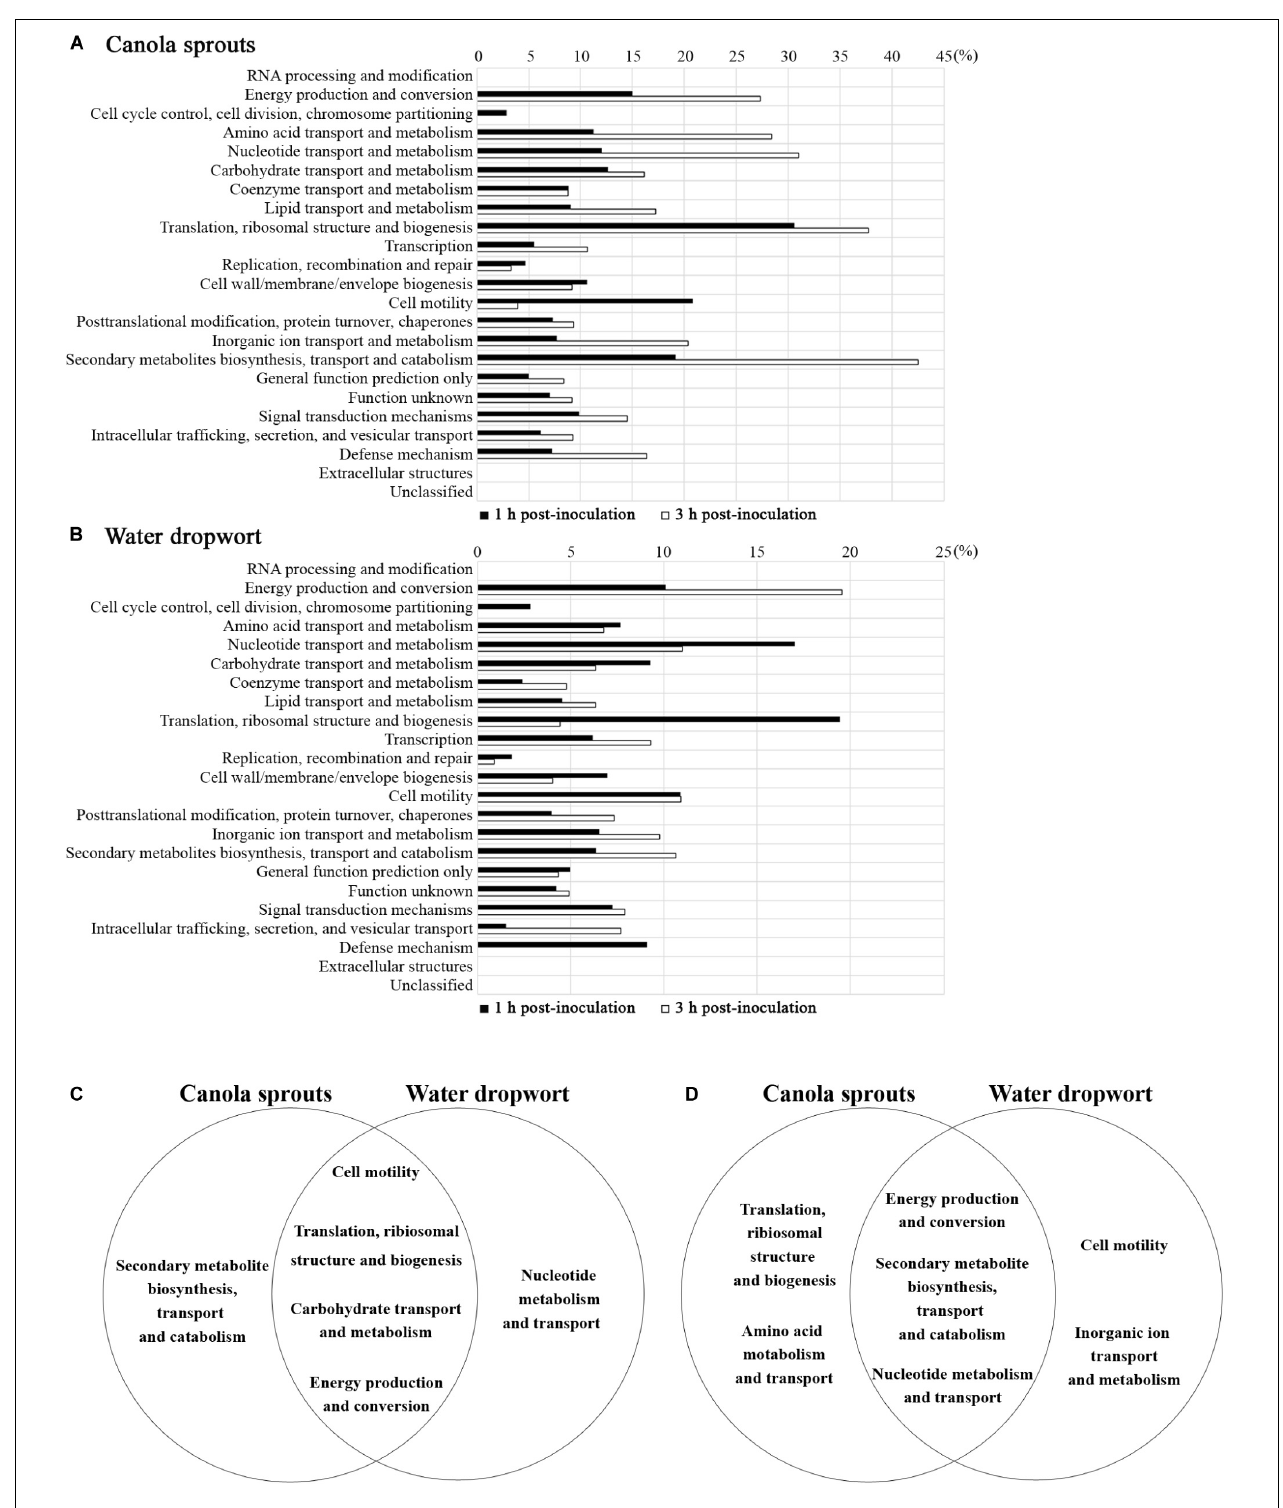
FIGURE 2 | Functional categorization of genes that were differentially regulated upon contact with plants. (A,B) Genes with log 2 [fold change] ≥ 2 or log 2 [fold change] ≤ –2 in response to canola sprouts (A) or water dropwort (B) were grouped based on COG. Bars represent the percentages of increased or decreased genes in a given category after 1 h of exposure ( (cid:4) ) or 3 h of exposure ( ). (C,D) Venn diagram illustrating functional groups with significant expression changes in contact with plants. Five top functional groups showing differential expressions in response to each plant were sorted at 1 h (C) and 3 h (D) post-inoculation. (cid:50) Functional groups identified in both of plants in common were placed in the intersections of the sets.